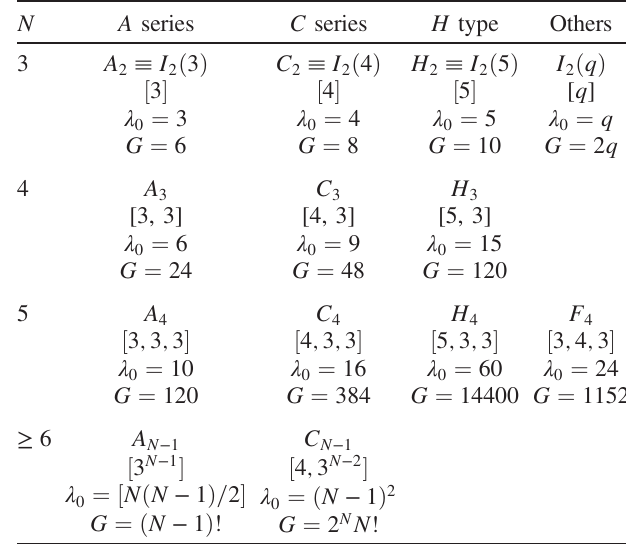
i ¼ 1 = 4 is in mass family A 3 . i ¼